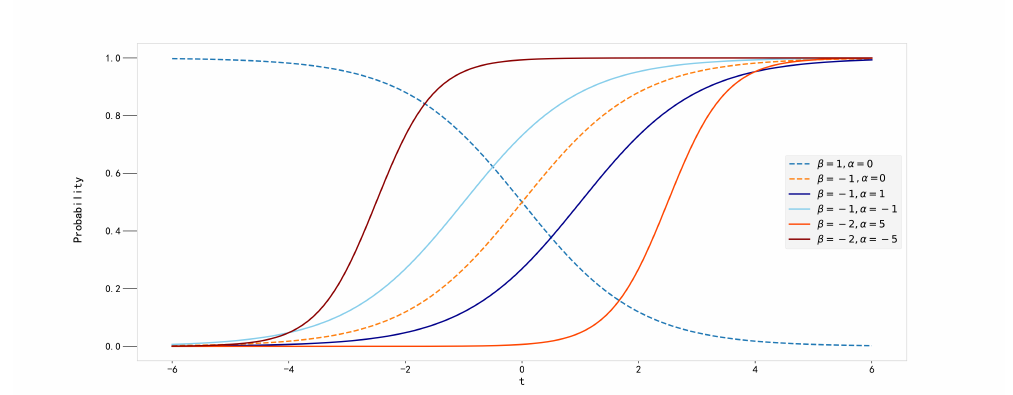
Figure 5. The logistic function with varying β and α .